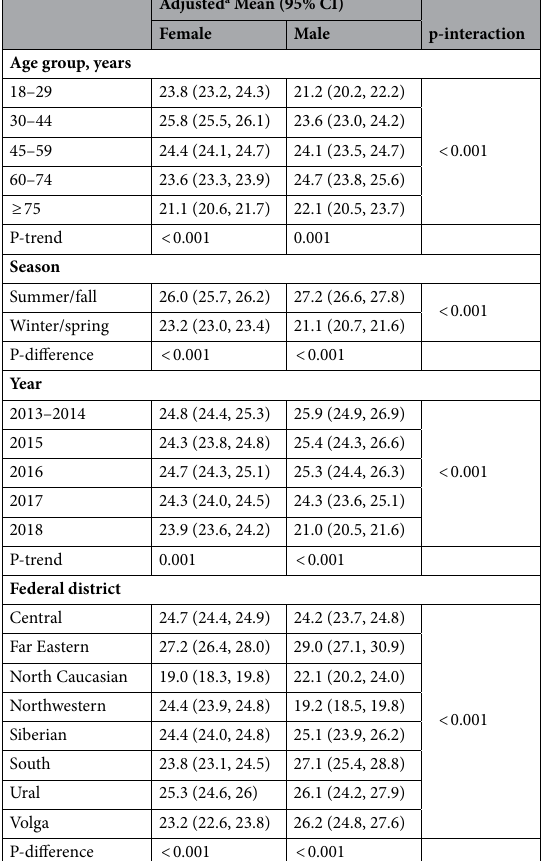
Table 2. Mean 25(OH)D concentrations by population sub-group, stratified by sex. Data are from 2013 to 2018 and are from all months of the year. a Values represent age group, season, year of data collection and federal district adjusted means estimated via marginal values following the fitting of a linear regression